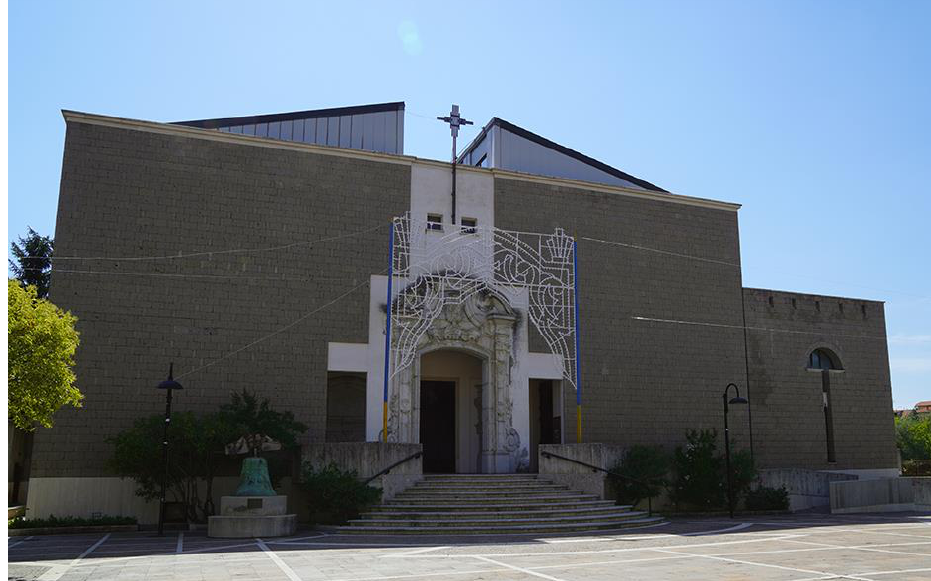
Figure 76. Torella dei Lombardi: the new Church of S. Maria del Popolo (photos by [35,36]).